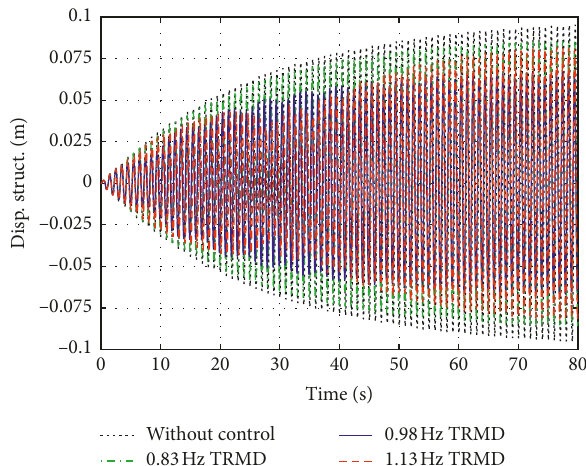
Figure 17: Response of the structure controlled by TRMD with different frequencies for free vibration.